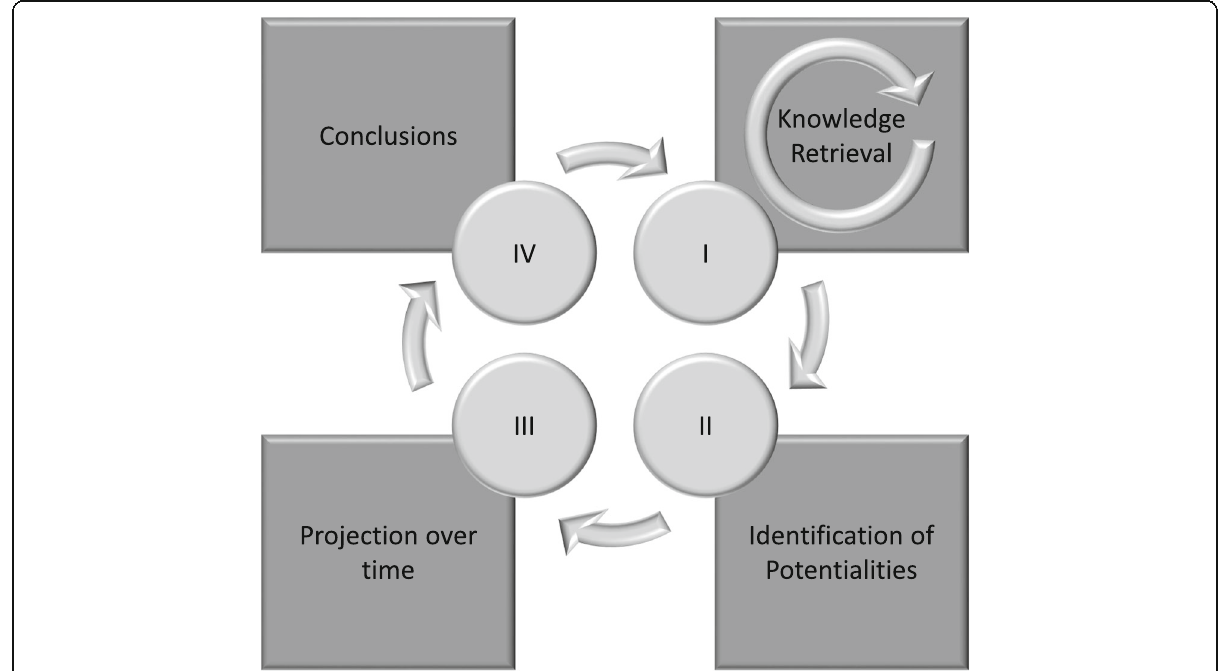
Fig. 1 Simplified model of foresight